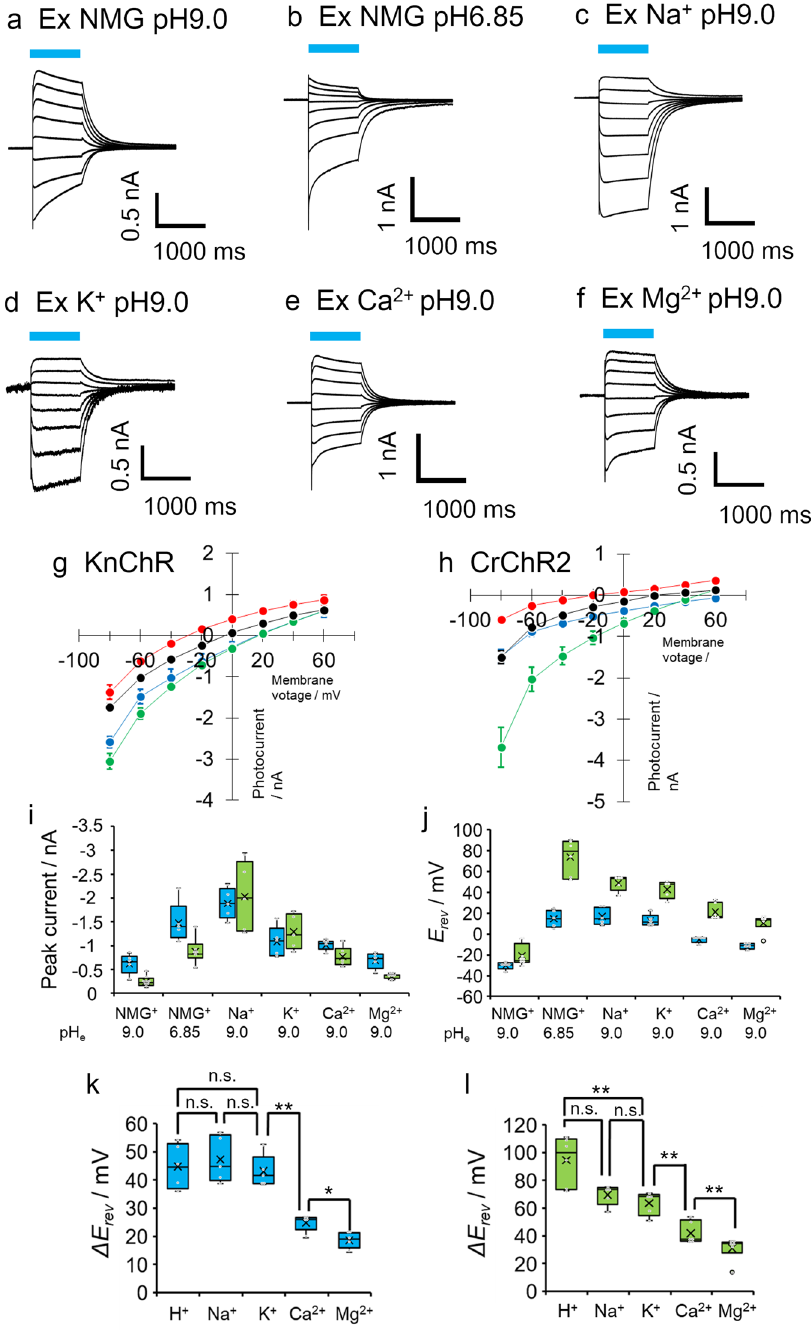
Fig. 6 Ion selectivity of KnChR and CrChR2. a – f Representative photocurrent traces of KnChR-272 under various cation conditions. Solutions were listed in Supplementary Table 1. Blue bars indicate light application (480 nm, 12.3 mW/mm 2 ). Membrane voltage was clamped from at − 90 to + 50 mV by 20 mV steps. I-V relationship of KnChR ( g ) and CrChR2 ( h ). The peak component of photocurrent was plotted. Red: Ex NMG pH 9.0, Blue: Ex NMG pH 6.85, Green: Ex Na + pH 9.0, Black: Ex Ca 2 + pH 9.0. i Comparison of peak current amplitude under various ionic conditions at − 60 mV. light blue, KnChR; green CrChR2. j Reversal potential E rev under various solutions. k Reversal potential shift ( Δ E rev ) of KnChR. Δ E rev of each cation was calculated by subtracting E rev of each ionic condition in ( j ) by E rev of NMG + at pH e 9.0. e.g., Δ E rev of H + is determined as E rev (NMG + pH e 6.85) - E rev (NMG + pH e 9.0). l Reversal potential shift ( Δ E rev ) of CrChR2. Data were presented as the mean ± SEM. N = 5 (all the conditions for KnChR). N = 8 (CrChR2 in NMG pH 9.0), 6 (CrChR2 in NMG pH 6.85), 5 (CrChR2 in Na + pH 9.0), 5 (CrChR2 in K + pH 9.0), 6 (CrChR2 in Ca 2 + pH 9.0), and 6 (CrChR2 in Mg 2 + pH